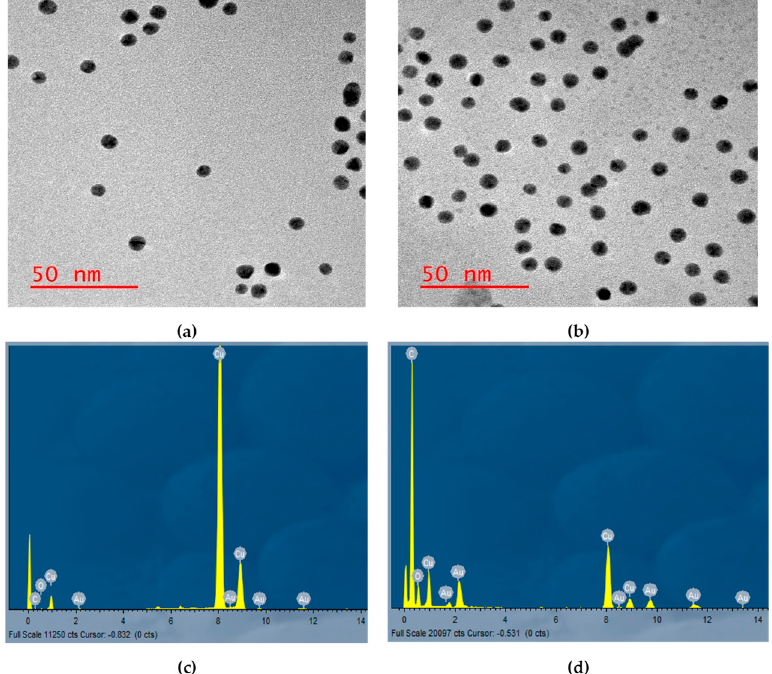
Figure 3. Item Analysis using HR-EM showing the presence and intensity of single elements loaded onto the Cu grids. ( a ) AuNP alone, ( b ) the compound showing an average monodispersion and size averaging 10 nm, ( c ) AuNP alone showing high presence of Au atoms, and ( d ) the compound showing high intensity of C from the C ring of the hypericin molecule and O from the hydroxyl groups.